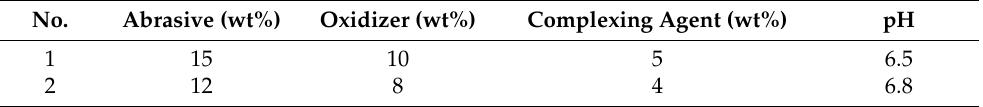
Table 3. Composition of the polishing slurry.